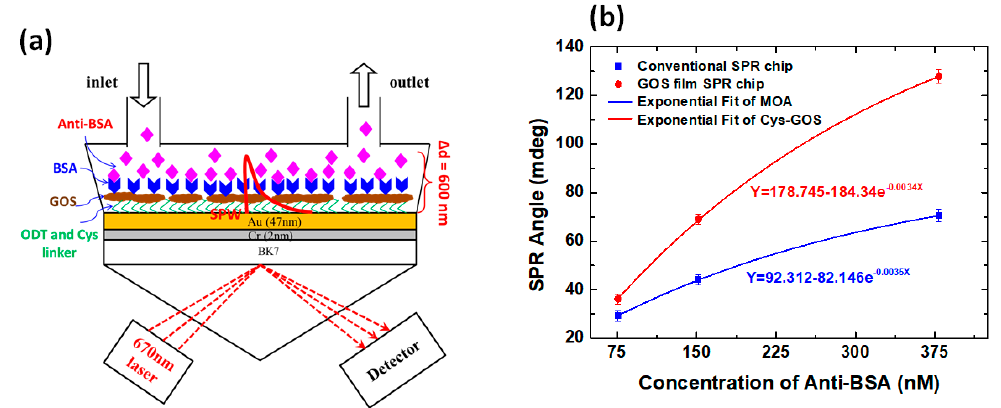
Figure 7. ( a ) GOS based SPR structure. ( b ) The response of the SPR biosensor at different anti-BSA concentrations (adapted with permission from Reference [40], copyright Springer Nature).